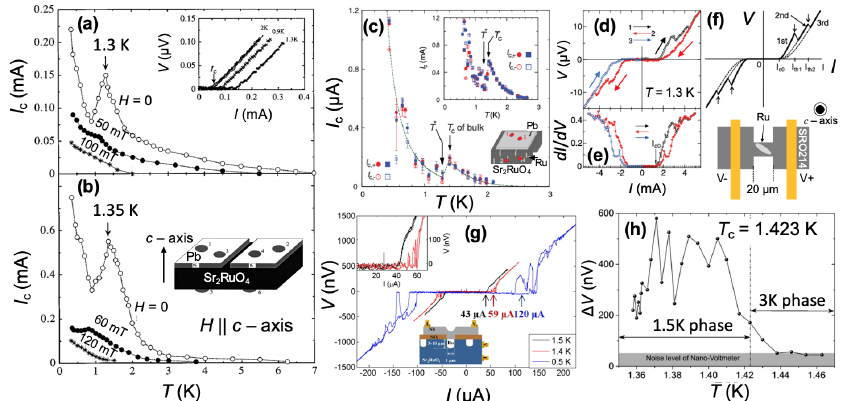
Figure 7. Critical current behaviour of Josephson junctions with SRO214-Ru eutectic single crystals. ( a , b ) Temperature-dependent critical current ( I c ( T ) ) of the Pb/SRO214/Pb Josephson junction, as shown in the inset. A sharp I c suppression at bulk T c is observed, which is suppressed with the applied magnetic fields. (Adopted from [74] copyright APS 1999) ( c ) I c ( T ) of a Pb/Ru/SRO214 junction indicating similar I c suppression. The inset shows that I c ( T ) is stable at T > T c − bulk , but it is unstable for T < T c − bulk . (Adopted from [75] copyright APS 2011) ( d , e ) Current-voltage ( IV ) curves and differential conductance of a junction prepared using FIB and keeping a single Ru inclusion between two SRO214 bulk parts. Close to the T c (1.3 K), sweep sensitive switching in current and dV / dI are observed. ( f ) A schematic of I c switching and configuration of the junctions. (Adopted from [78] copyright APS 2008). ( g ) IV curves at different temperatures of a Nb/Ru/SRO214 topological junction based on a single Ru inclusion, as shown in the inset. The I c is switching between superconducting and normal states. (Adopted from [35] copyright NPG 2013) ( h ) Temperature- dependent switching effect that is totally suppressed in the 3-K-phase. (Adopted with permission from [36] copyright APS